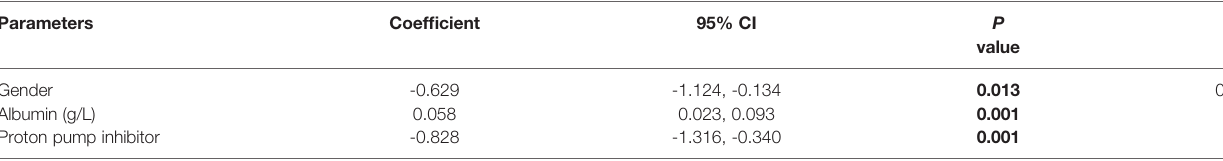
TABLE 4 | The multiple linear regression analysis for dose- normalized PCZ concentration.